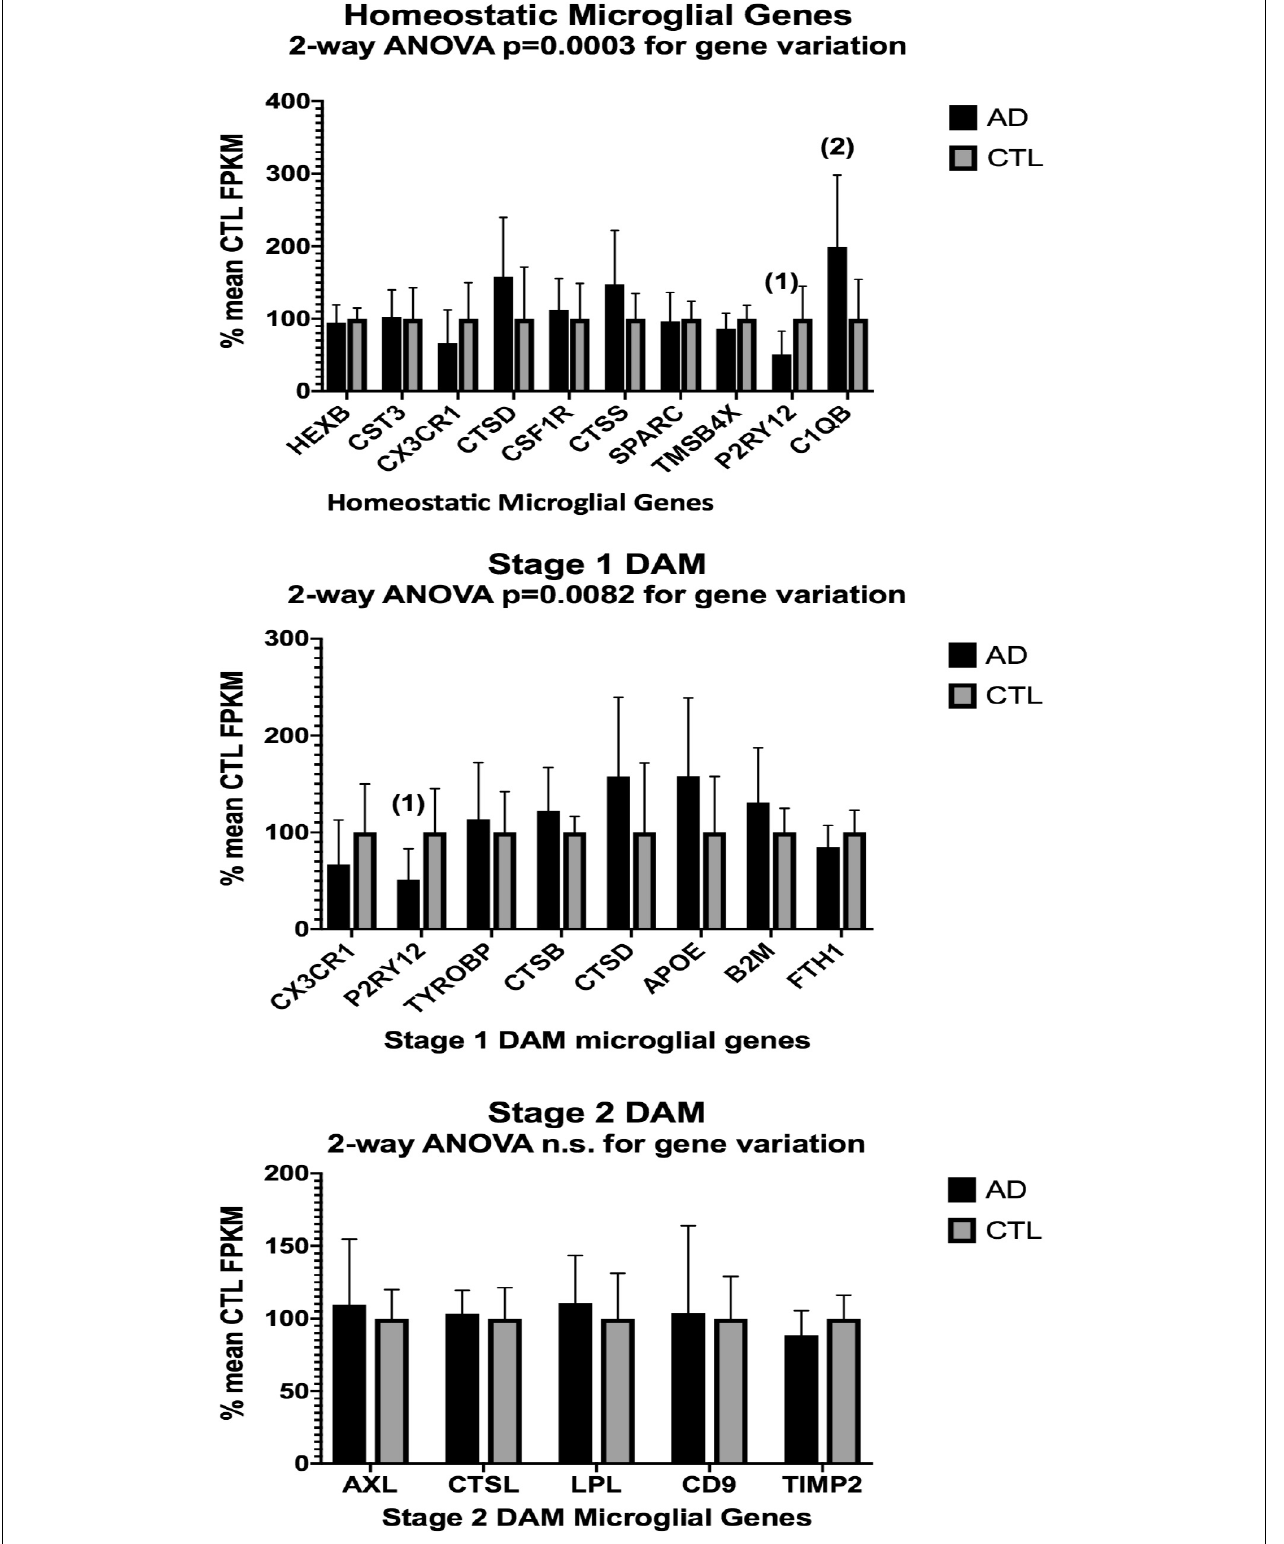
FIGURE 4 | Same as Figure 3 , except for AD ( n = 10) and CTL ( n = 9) frontal cortical ribbons. Alignments against the hg38 human genome were carried out with HISAT2 and quantitated with Cufflinks. Two-way ANOVA results are given in each graph. Unpaired t -test results are as follows: (1), p = 0.014; (2), p = 0.016.